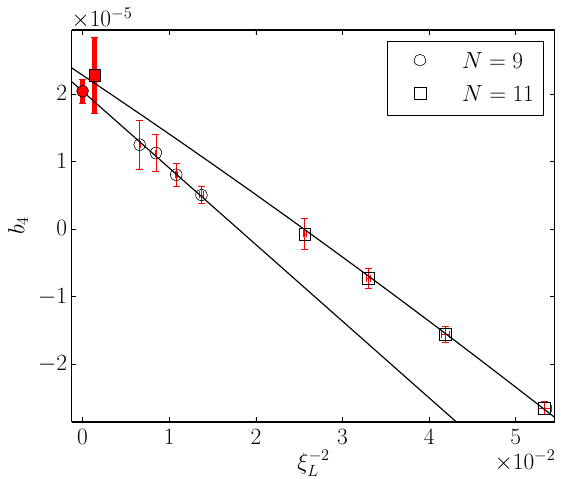
Figure 11 . Extrapolation to the continuum limit of b 4 for N = 9 and 11. Continuum values are reported as filled symbols and are slightly shifted horizontally to increase